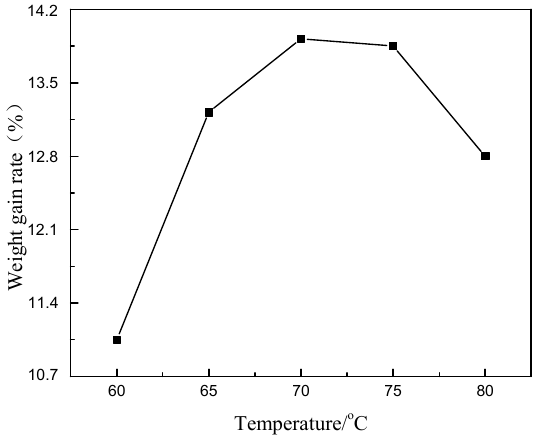
Figure 6. Effect of temperature on the weight gain rate.